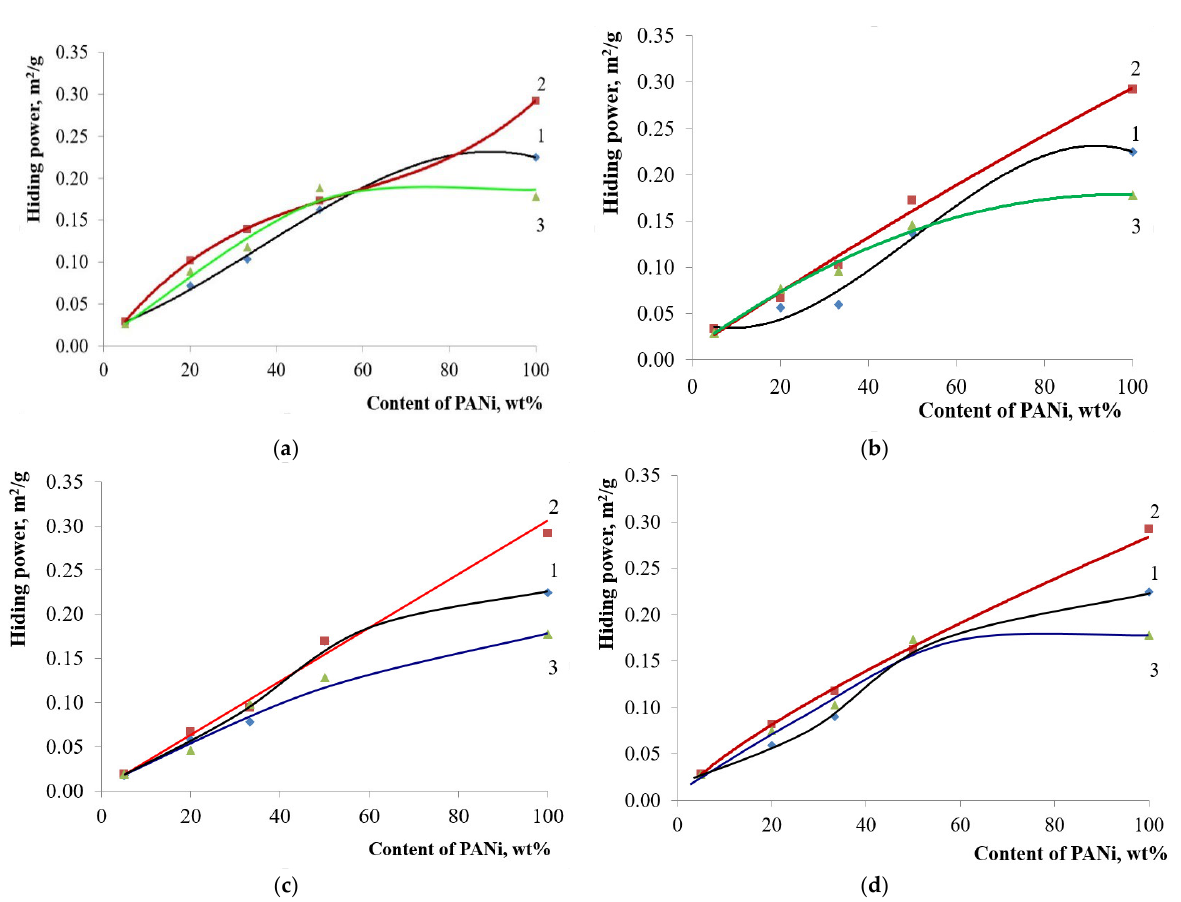
Figure 9. Hiding power of core/shell pigments with a various base vs. the content of PANi doped with various acids: ( a ) kaolin-based core/shell pigment; ( b ) bentonite-based core/shell pigment; ( c ) talc-based core/shell pigment; ( d ) muscovite-based core/shell pigment. Doping acid: (1)—H 2 SO 4 ; (2)— НСl; (3)—H 3 PO 4 . The same relation can be seen for the core/shell pigment-coloring strength (Figure 10)—it rises along with the increase in PANi content.